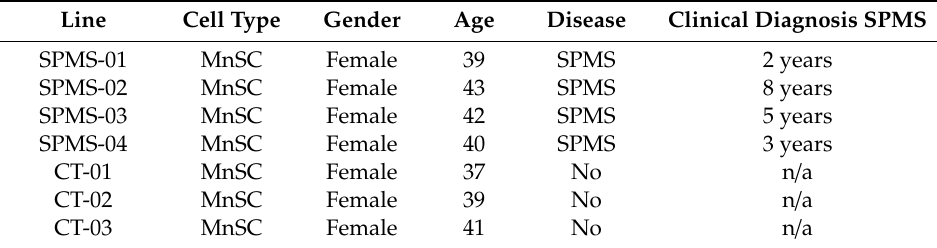
Table 1. Somatic cell donor